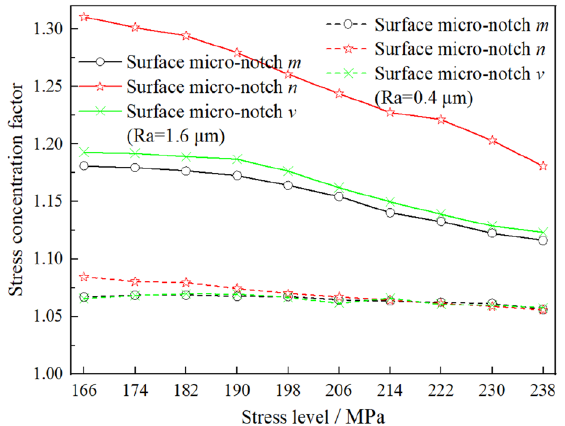
Figure 12. Stress concentration factors of different micro-notches under the different stress levels. (Calculated by revised